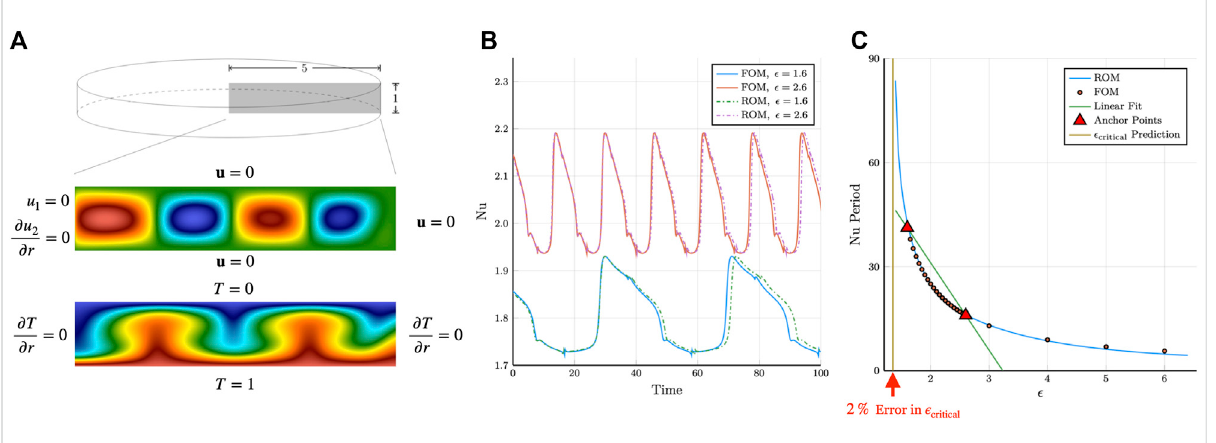
FIGURE 1 ROM application to axisymmetric Rayleigh –